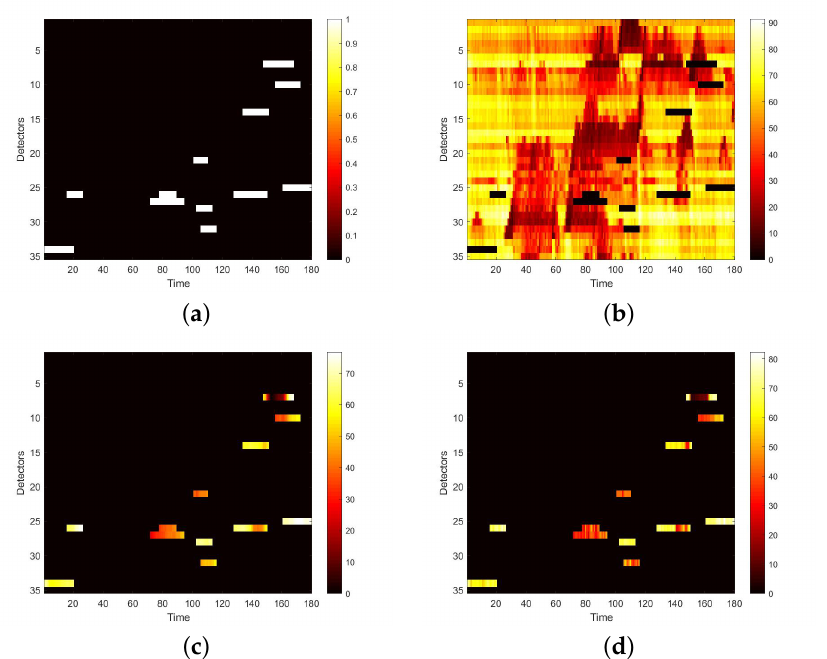
Figure 10. Speed matrices of Yan’an elevated highway (the 8th day of testset) with strip damage visualized as heat maps. ( a ) Mask matrix visualized as a heat map. ( b ) Damaged speed matrix visualized as a heat map. ( c ) Repaired speed matrix visualized as a heat map. ( d ) Real speed matrix visualized as a heat map.